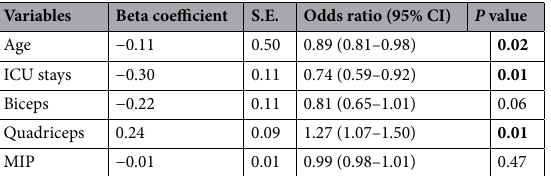
Table 4. Multivariate logistic regression for regaining ambulation ability of potential predictor after ICU discharge. Bold values are statistically significant.